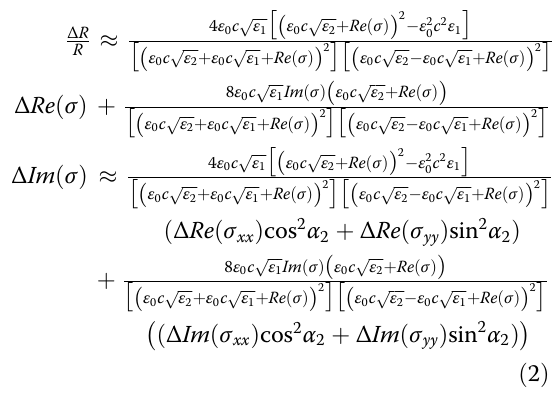
Fig. 4 Dynamical evolution of anisotropic response. a The dependence of transient re fl ection signal on the polarization angle of the probe at fi xed pump polarization and delay time at room temperature. The pump power is 300 μ W. The angular dependence is fi tted by Δ R / R = C φ ) + C φ ), where α 2 ( α 2 sin 2 - 2 is the angle between the probe polarization and Δ R / R reaches the maximum when α = φ . b Dynamical evolution of Re ( σ ) ellipse, here the pump induced conductivity changes Δ Re ( σ ) = Re ( σ )| 2 − Re ( σ )| on pump off have been tripled for